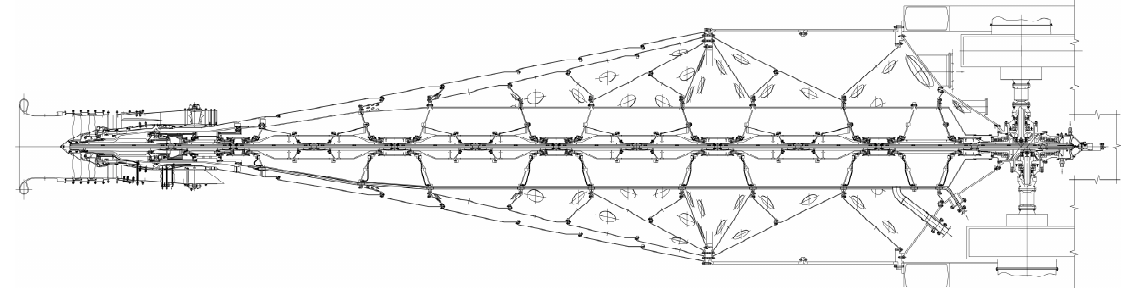
Figure 4. The cantilever of the C-3A test facility is composed of modules with a specific length